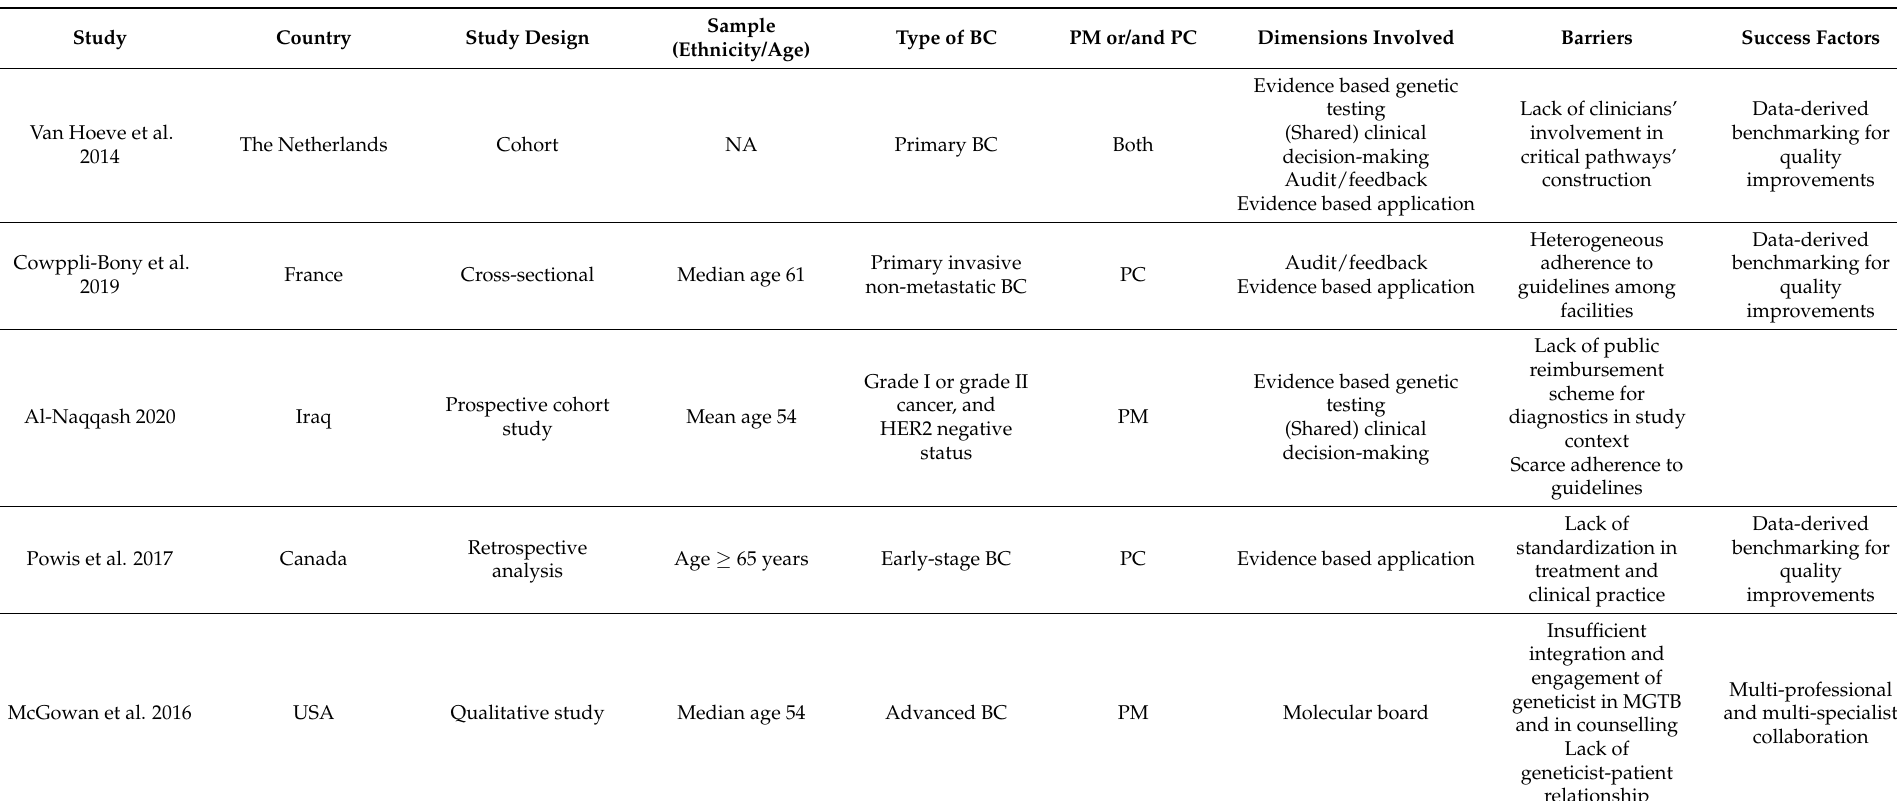
Table 2. Summary of 25 studies on Breast Cancer management, evaluated in terms of Patient-Centered and Personalized Medicine approaches, assessing success factors and/or barriers. Articles are listed in study design